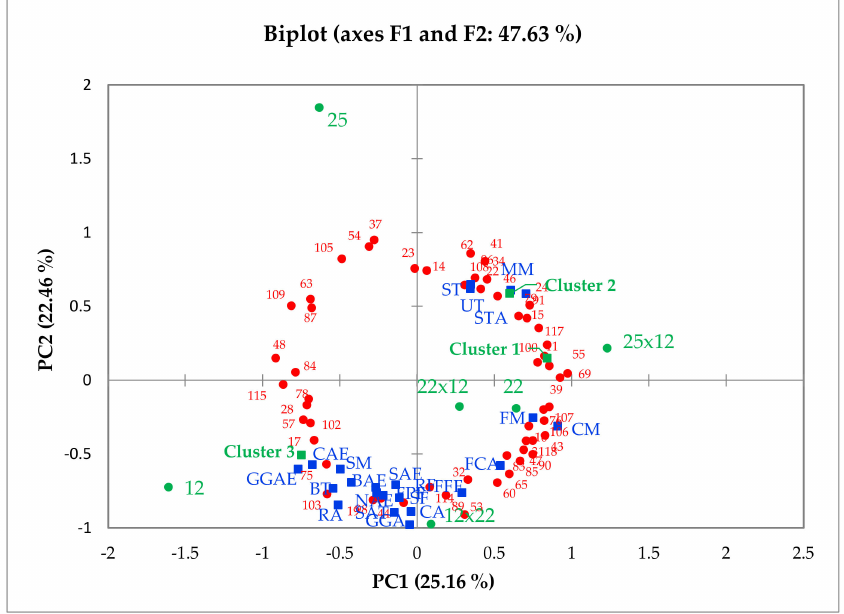
Figure 3. Internal preference map of six celery samples. Sensory attributes and consumer cluster means were regressed onto the consumer preference matrix generated by PCA. Blue squares—sensory attributes, codes correspond to those in Table 2. Green squares—clusters 1, 2, 3, mean liking positions of three clusters from AHC (Table 6). Red circles: overall liking scores of each